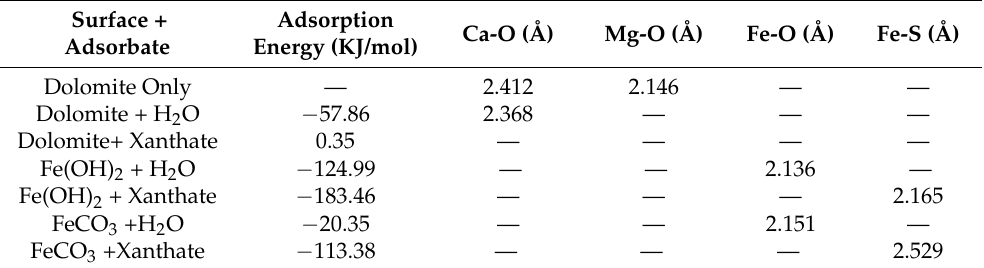
Table 1. Adsorption energy and main interatomic distances (in Å) between adsorbates and slab surface (the lower of the adsorption energy values, the stronger of the adsorption